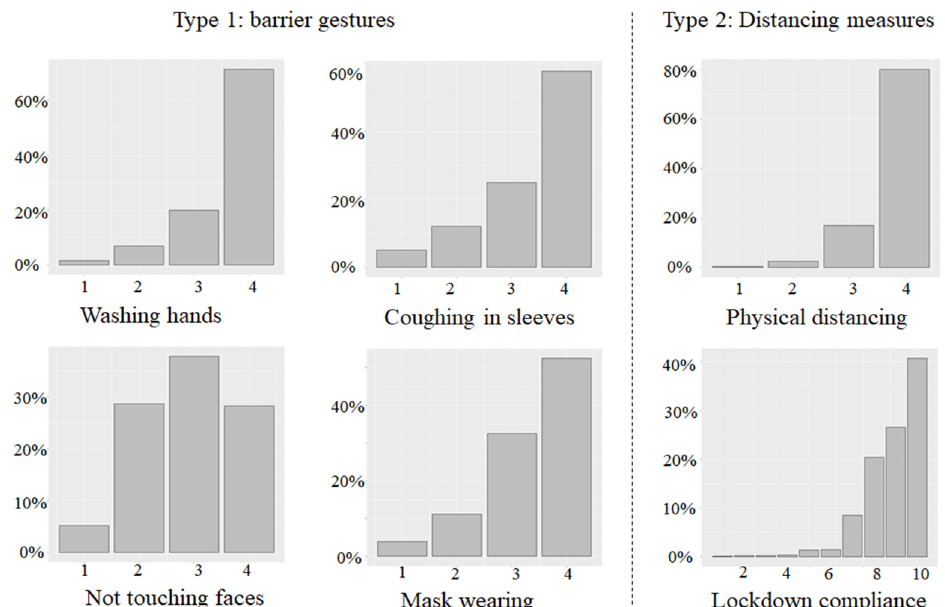
Figure 4. Compliance with each prophylactic measure. Note: For all measures except lockdown compliance: 1 = “Never”, 2 = “Sometimes”, 3 = “Often” and 4 = “Very often”. For lockdown compliance: degrees of compliance from 1 (“Not at all”) to 10 (“strictly”).